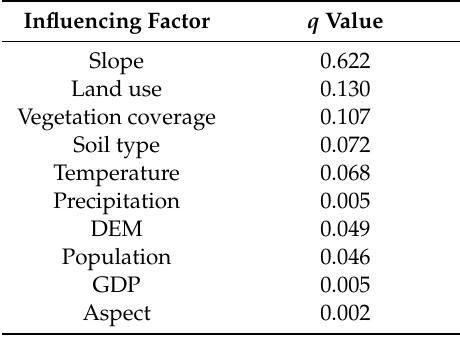
Figure 7. Influencing factors on soil erosion in the TGRA from 1990 to 2015. Table 3. Average q values of influencing factors in the TGRA from 1990 to